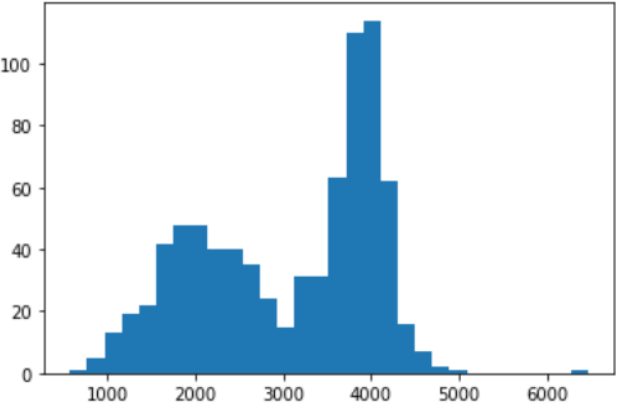
Figure 6. Histogram of passengers in the afternoon on bus line